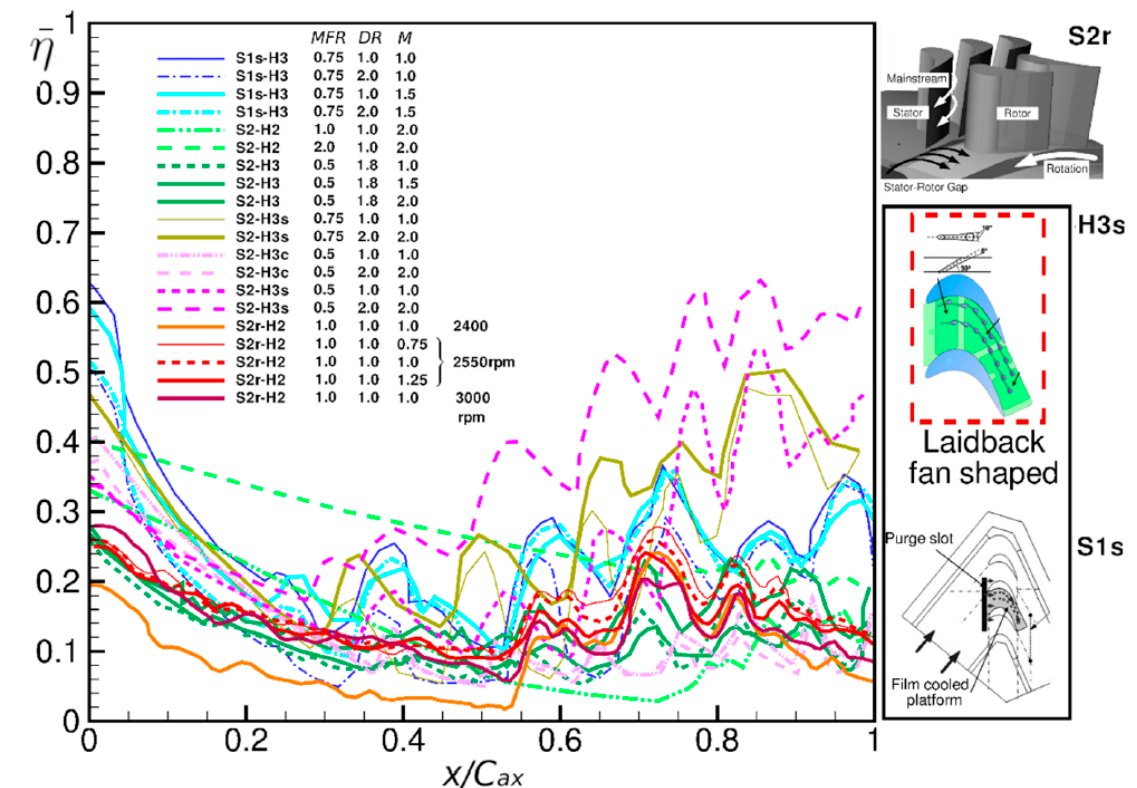
Figure 10. Film effectiveness curves can be complex and can have downward and upward trends [28] (courtesy: MDPI open source).